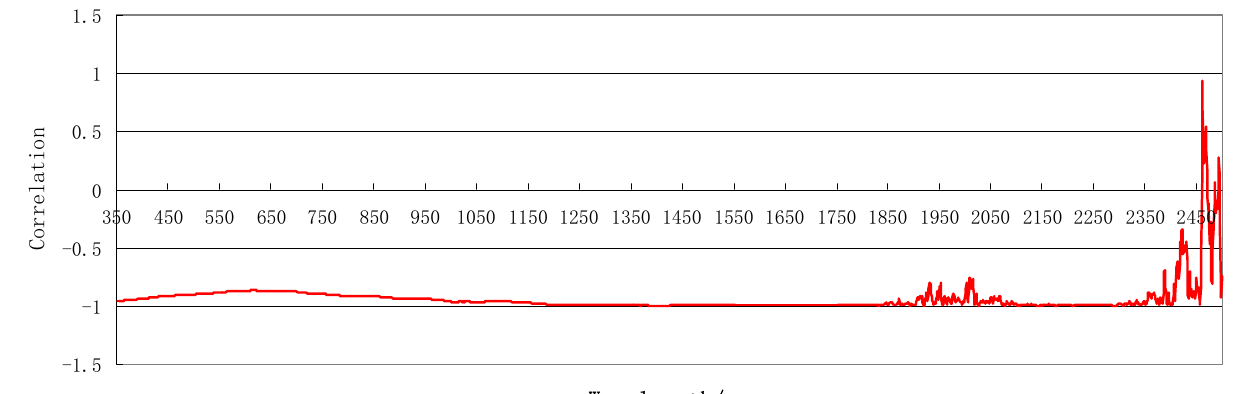
Figure 7. The correlation coefficients between the grain size and light